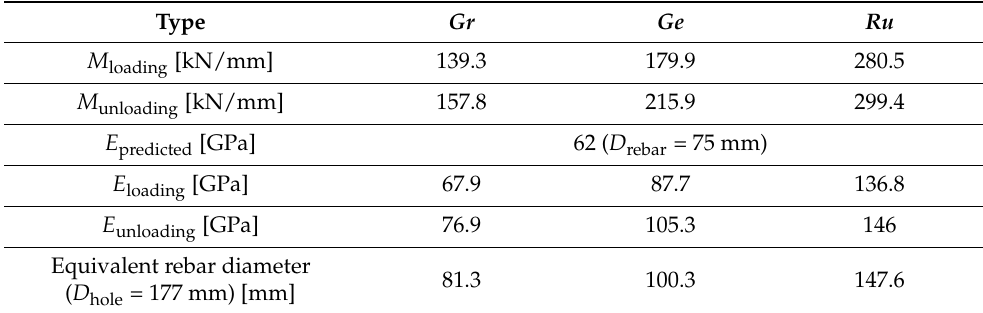
Table 3. Pullout modulus of micropiles in the elastic